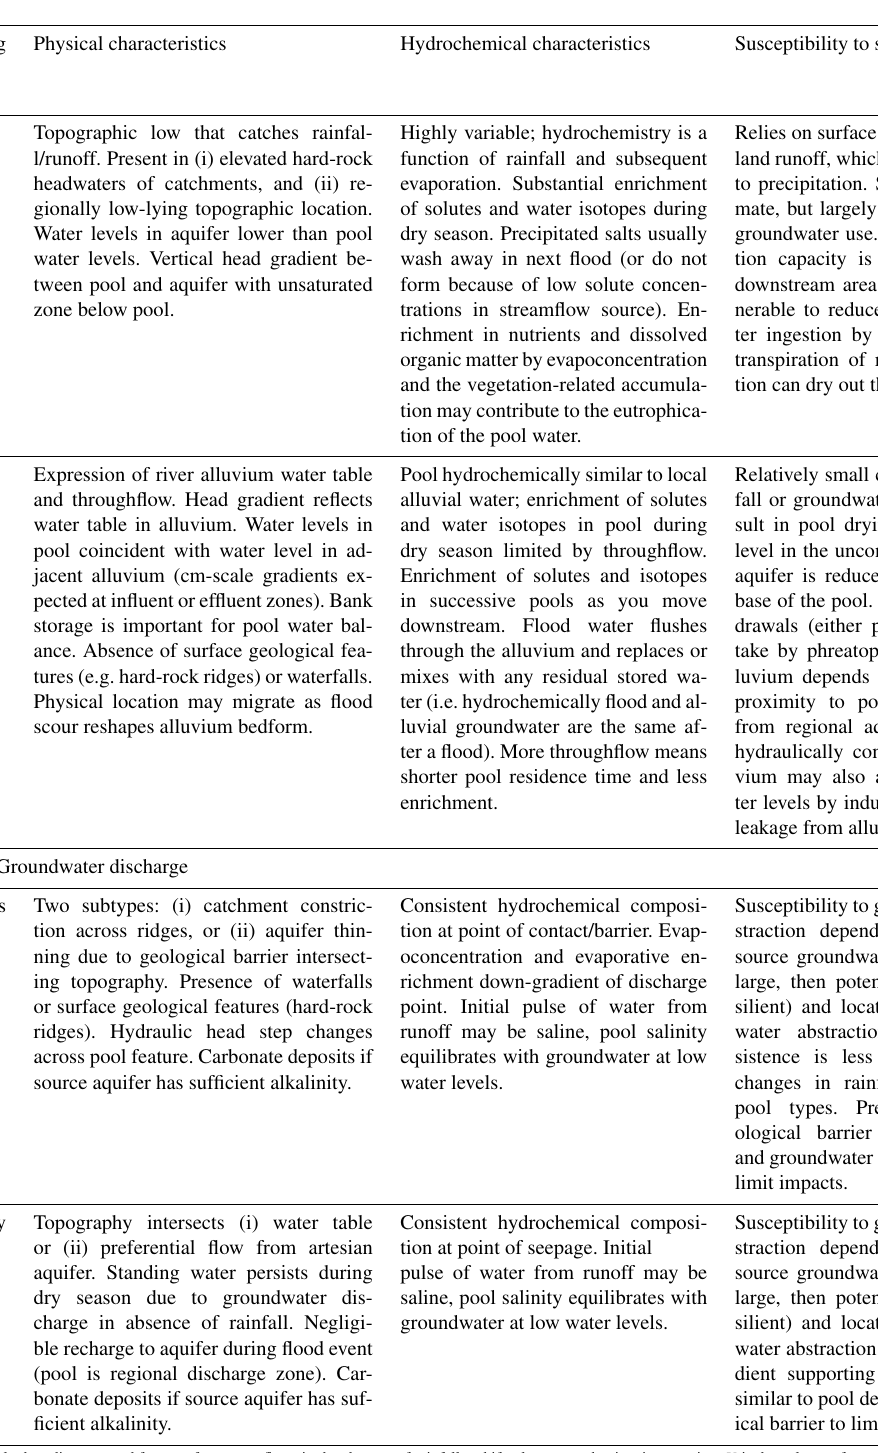
Table 1. Summary of hydrological framework for persistent